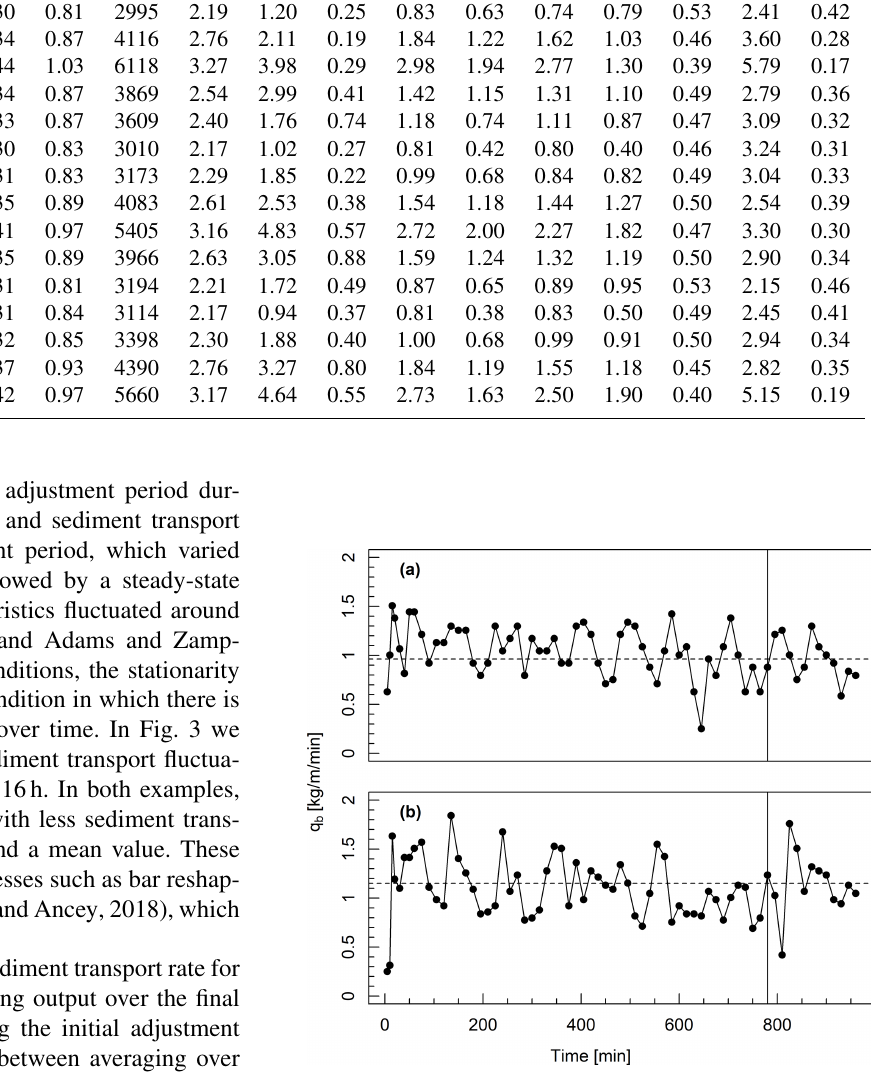
is the standard deviation of unit bedload b